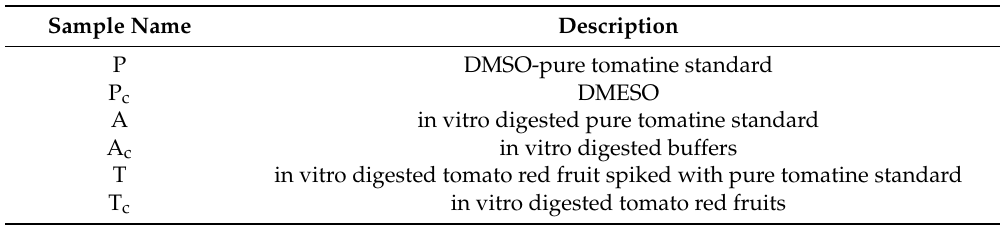
Table 1. Samples used in this